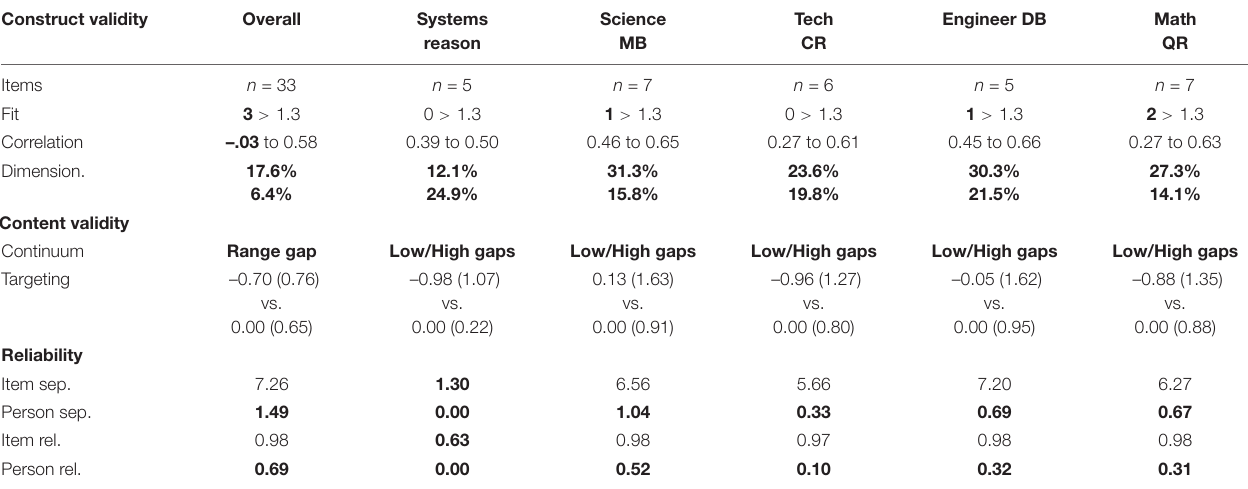
TABLE 4 | Student STEM Reasoning Assessment validity and reliability